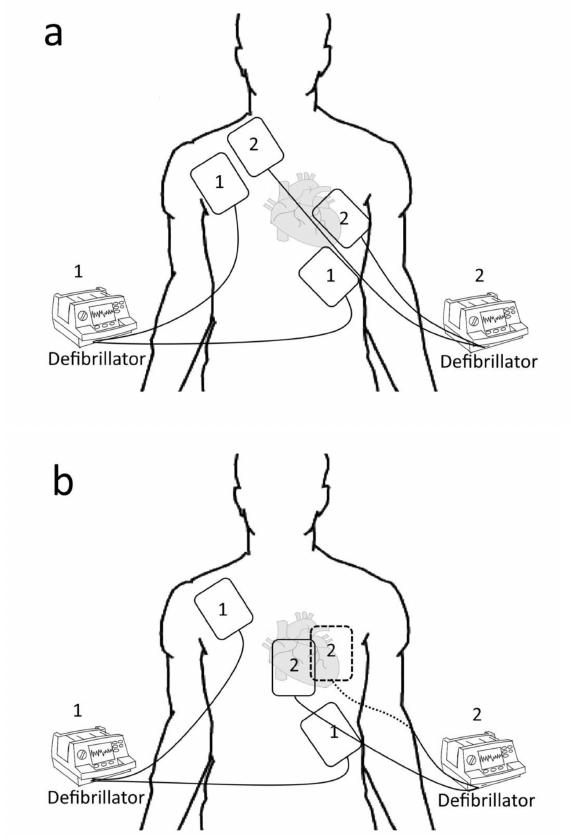
Figure 3. Two types of setting in DSD: ( a ) place another set of pads next to the original set in an anterior–lateral position; ( b ) place another set of pads in anterior–posterior position, with the anterior pad at the precordium region, and the posterior pad at the left or right infrascapular